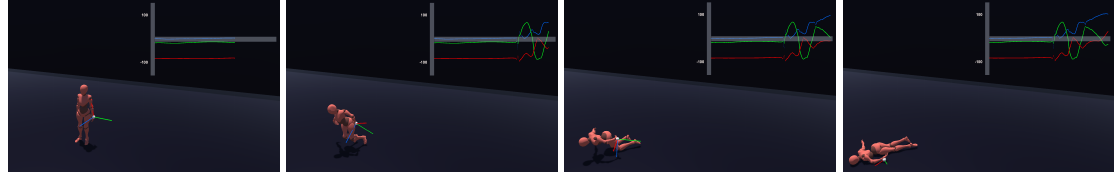
Figure 3. Recreation of a syncope fall in the simulator. Triaxial accelerometer measures are provided in the top-right of each